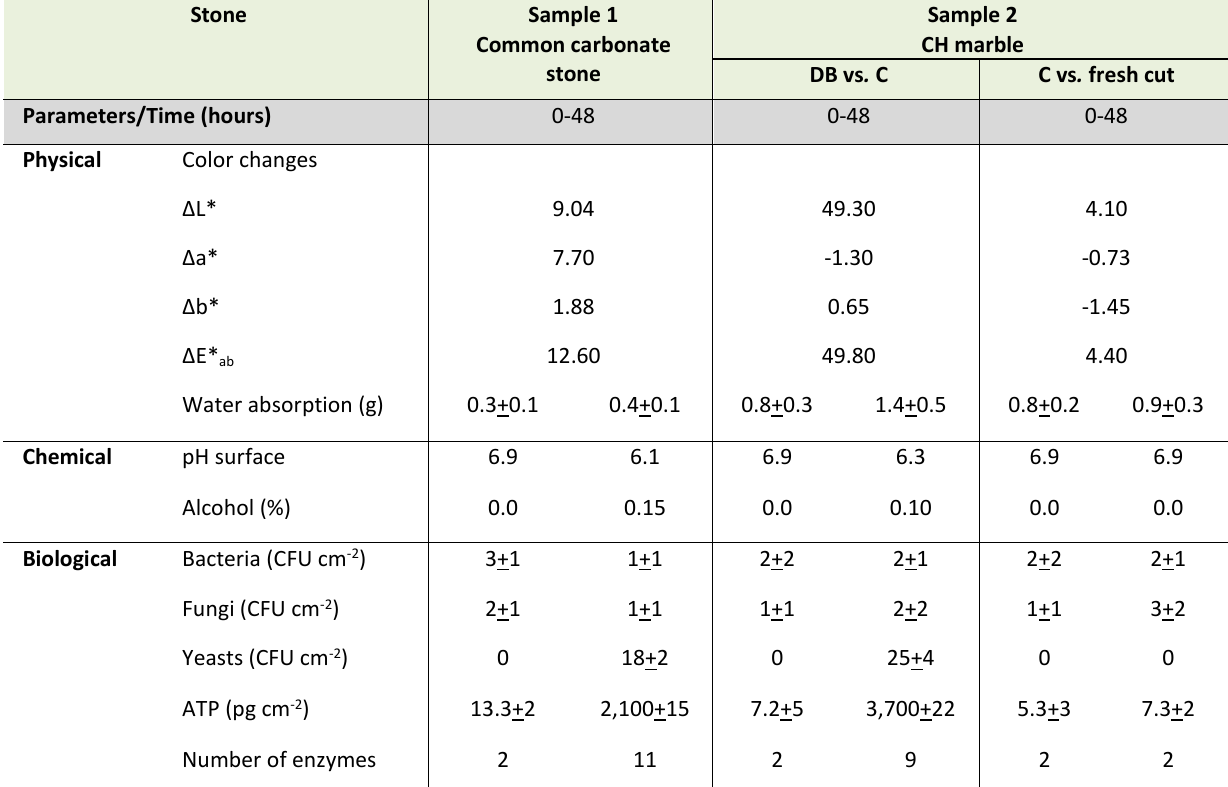
TABLE 1. Main physical-chemical and biological data on the surfaces of both the common carbonate stone (sample 1) and CH marble (sample 2) fragments, before (T0) and after (T48 hours) the dry biocleaning (DB) process, at the laboratory scale (three replicates, mean +